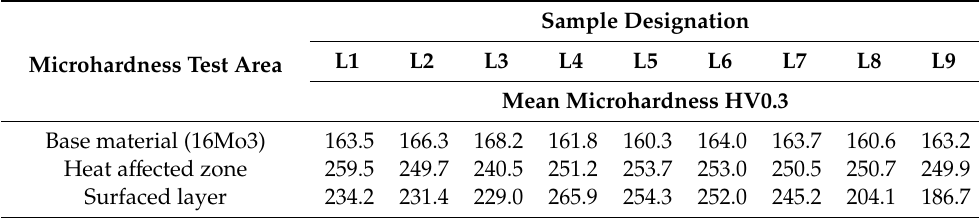
Table 11. Average microhardness HV0.3 measured on the cross-section of 16Mo3 steel pipes laser clad with Inconel 625 superalloy powder (Table